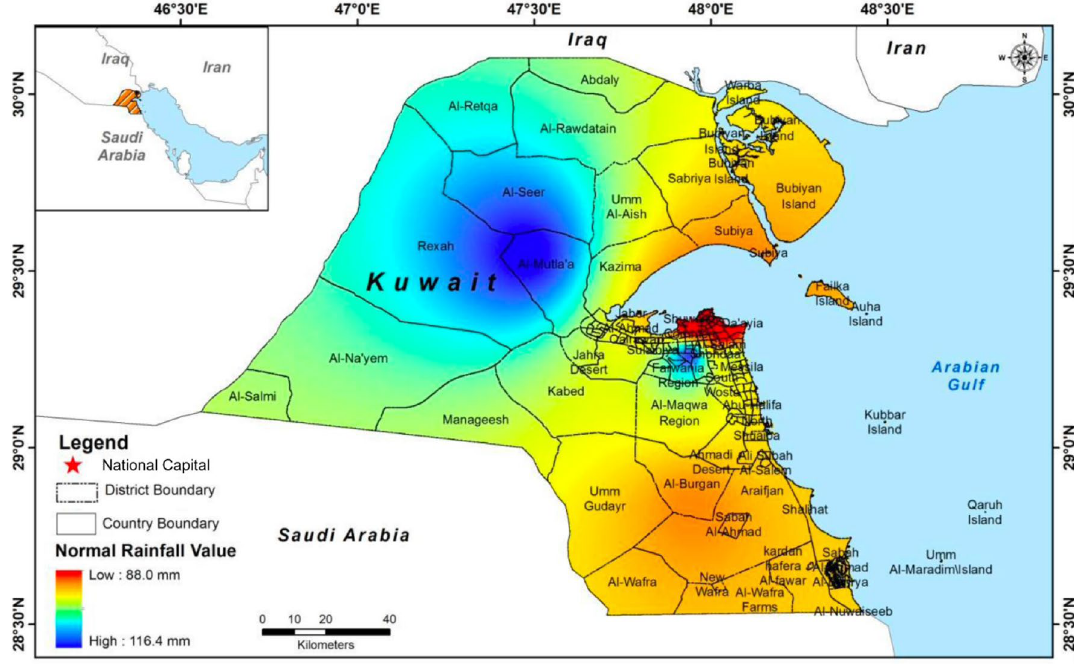
Fig. 7 Average annual rainfall spatial distribution map for the rainy season (October–May) in Kuwait, 1981–2018. Source Kuwait Institute for Scientific Research